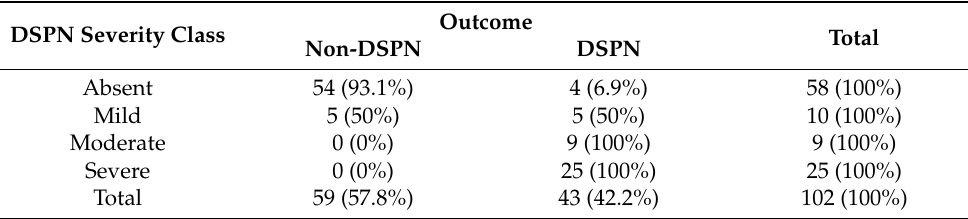
Table 9. The association among different DSPN severity groups and actual outcomes in the indepen- dent test dataset from Watari et al. [28], using Fisher exact probability test.